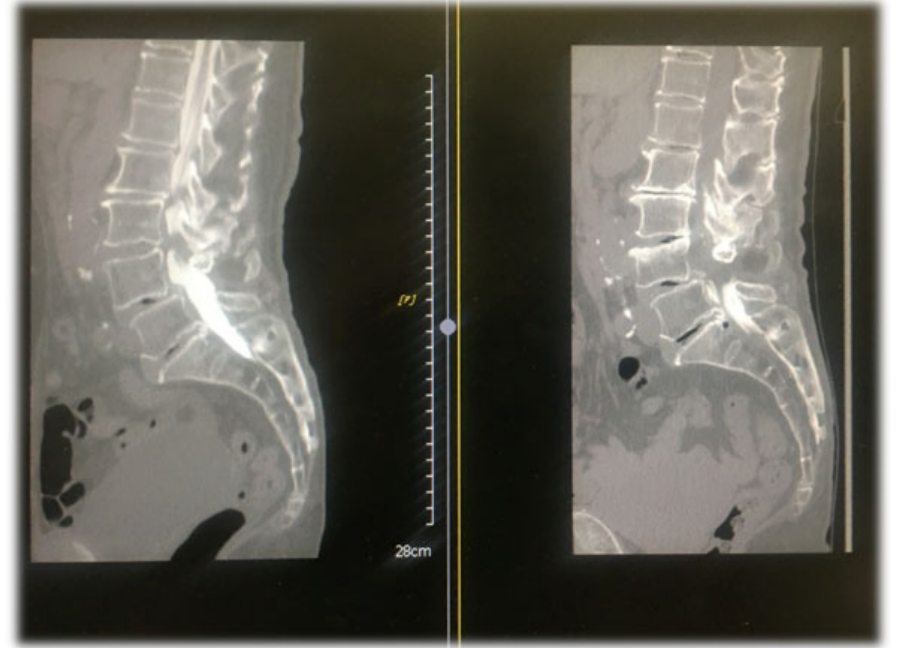
Figure 4. Epidural space adhesions. CT myelography sagittal view and CT epidurography sagittal view. CT, computed tomography; MRI, magnetic resonance imaging.